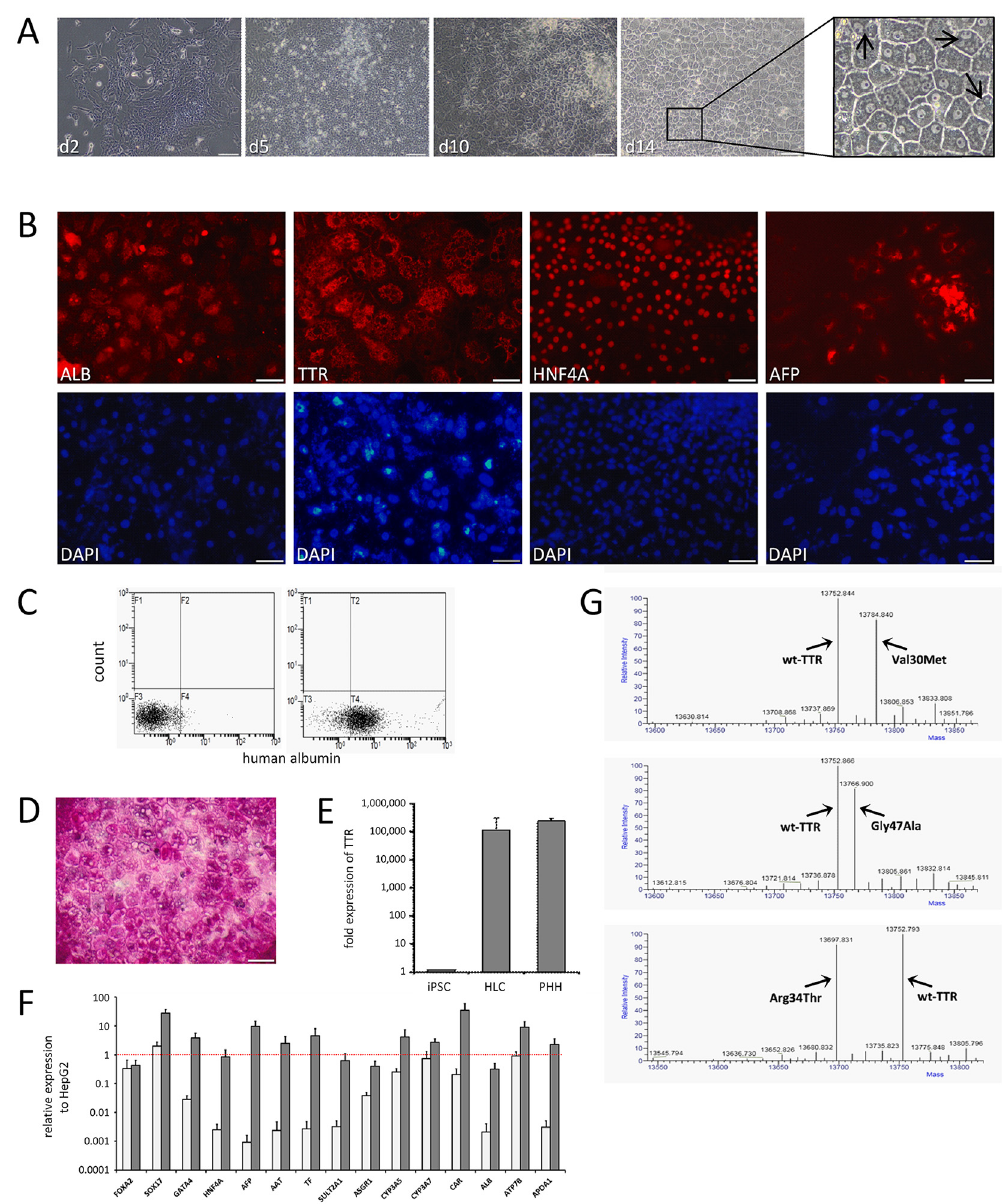
Fig 3. Generation of FAP iPS cell-derived hepatocyte-like cells. (A) Brightfield images of iPSCs at different days after in vitro differentiation. FAP5 derived cells are shown as one typical example. Scale bars, 100 μ M. Arrows in the zoomed area point to binucleated cells. (B) Immunofluorescence stainings of cells at day 14 of differentiation. FAP4 derived cells are shown as one typical example. Scale bars, 50 μ M. (C) Albumin flow cytometry analysis cells at day 14. FAP1 derived cells are shown as one typical example. (D) PAS staining of HLCs to indicate glycogen synthesis. FAP4 derived cells are shown as one typical example. (E) TTR mRNA expression in HLCs. Mean ± SE of FAP1 to FAP5 are shown. Primary human hepatocytes (PHH) are shown as control. Mean expression was normalized to housekeeping gene. (F) qRT-PCR analysis of FAP HLCs (grey) and respective iPSCs (white). Mean ± SE of FAP1 to FAP5 are shown. Dotted line indicates same expression relative to human hepatoma HepG2 reference cells line. (G) Mass spectral analysis of cell culture supernatants of HLCs derived from patients FAP1, FAP3 and FAP5 are shown. Arrows indicate peaks for TTR wild type and variant form.